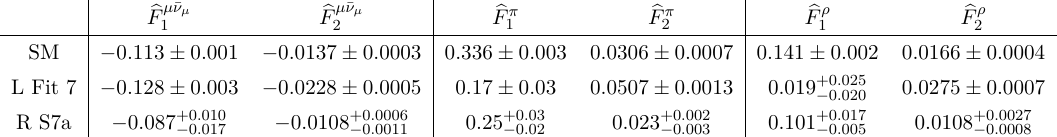
Table 2 . Predictions for the angular moments b F d evaluated in the SM and the same NP scenarios considered in table